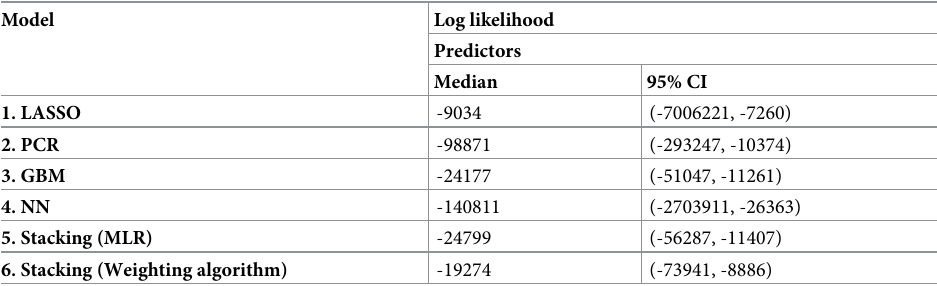
Table 3. Table of binomial log likelihood calculated from 6 models in 2000 bootstrapped datasets sampled from the dataset collated from systematic review. In each bootstrapped dataset we computed binomial log likelihood for each model. For each model summary statistics of the distribution of log likelihood was presented. Abbreviations: LASSO: Least Absolute Shrinkage and Selection Operator; PCR: Principal Component Regression; GBM: Gradient Boosting Machine; NN: Neural Network; MLR: Multiple Linear